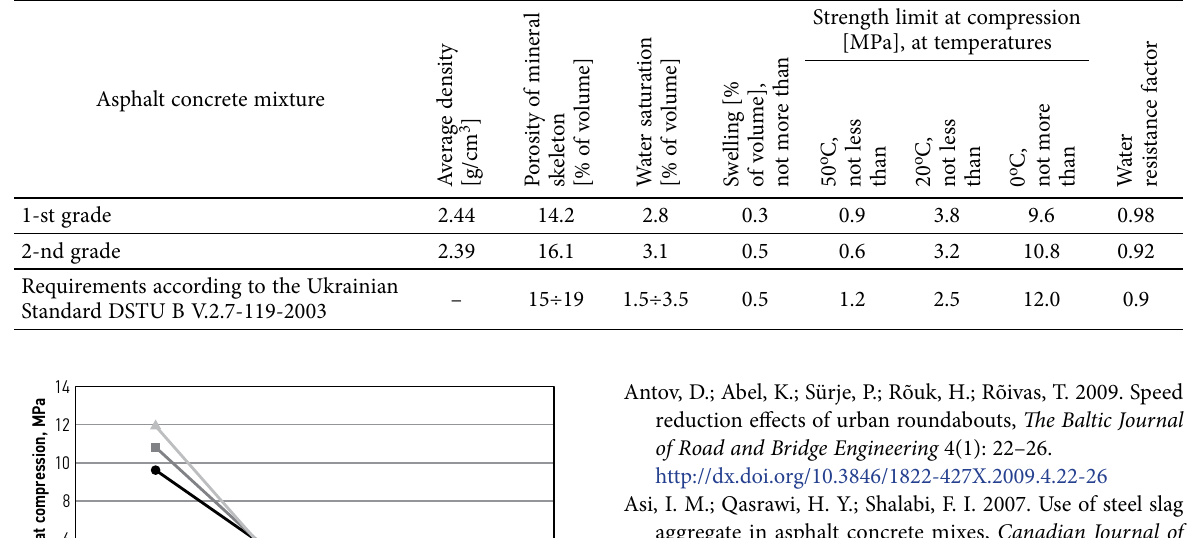
Strength limit at compression [МPа], at